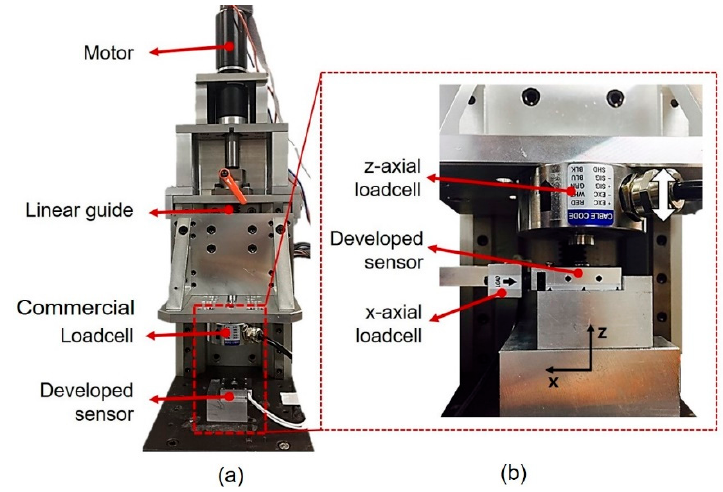
Figure 5. Experimental setup used to analyze the sensor characteristics. ( a ) An indenter used to analyze hysteresis, repeatability, and cross sensitivity. ( b ) Additional setup for the cross sensitivity analysis of the normal direction to the shear direction and the cross sensitivity analysis of the shear direction to the normal direction.